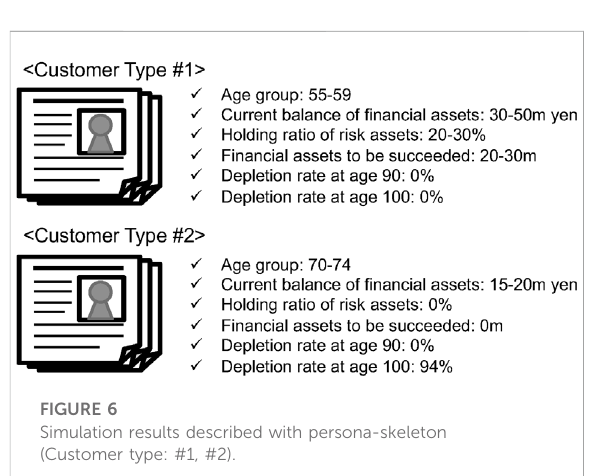
FIGURE 6 Simulation results described with persona-skeleton (Customer type: #1,